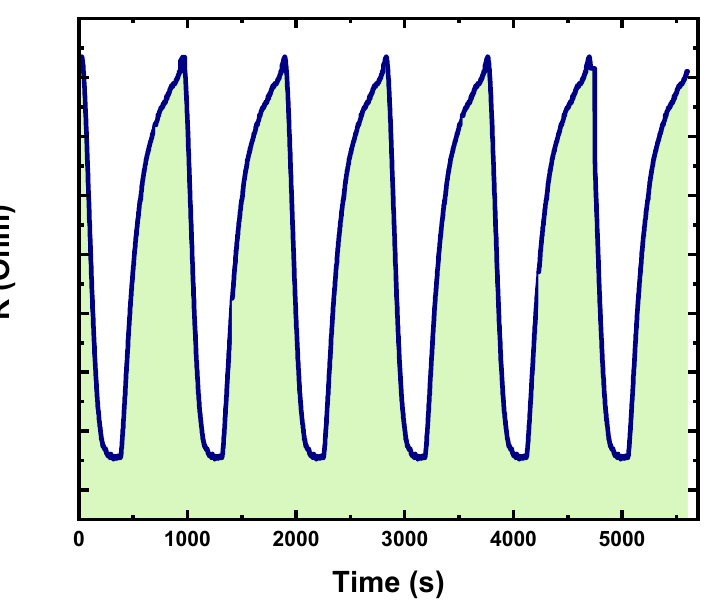
Figure 8. Repeatability test of the Ag NPs/V 2 O 5 thin film/Au NPs across eight repeats. To establish the long-time stability of the sensor, the gas response was assessed between 2 to 20 ppm acetone at its optimal temperature over a period of 45 days and the results obtained are shown in Figure 9. The sensor demonstrates excellent stability.